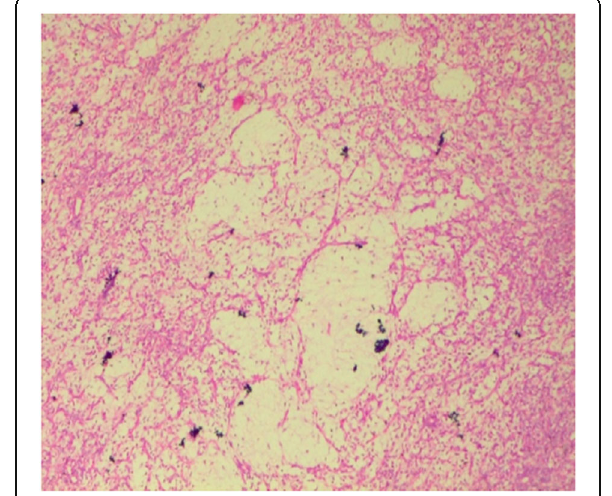
Fig. 3 Photomicrograph of excised specimen showing